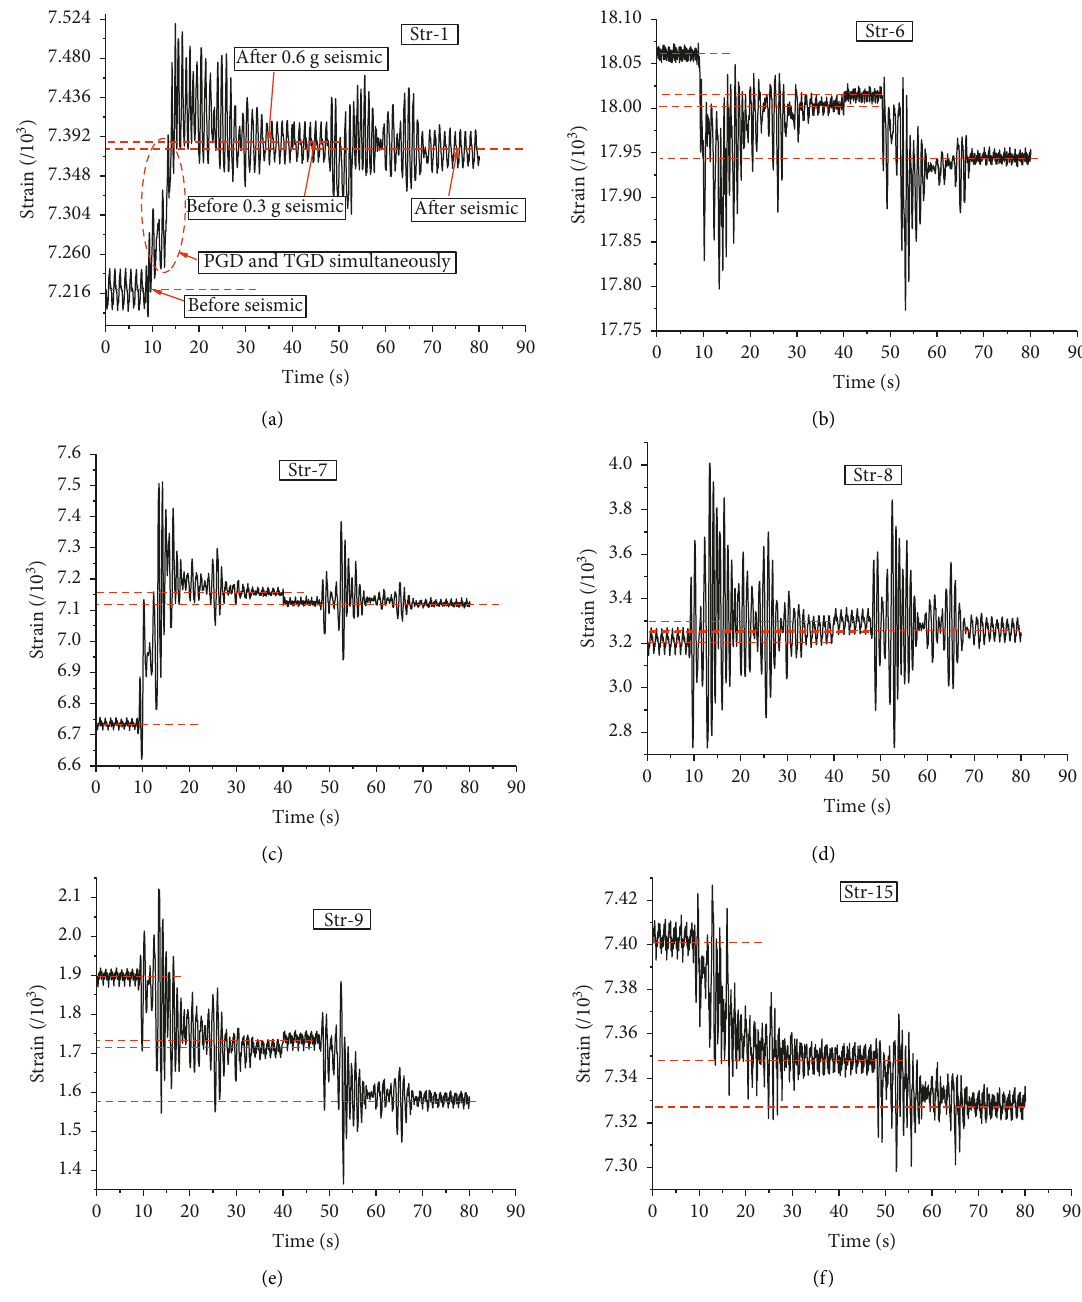
Figure 8: Time histories of strain of AL pipe under the seismic